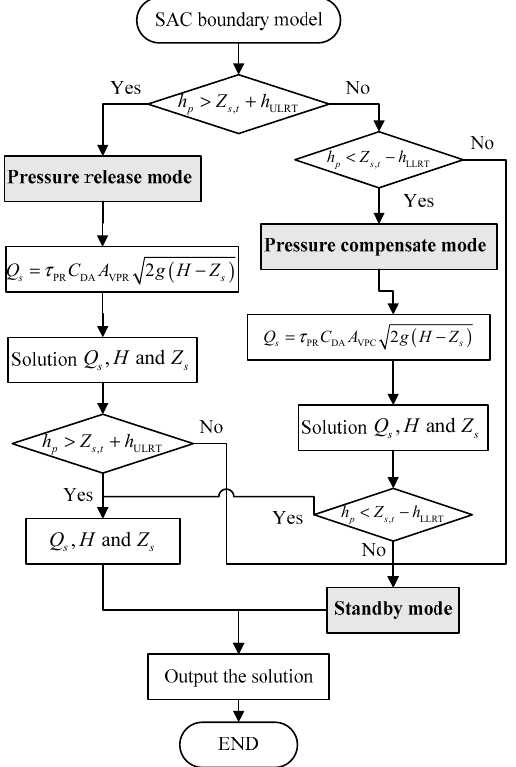
Figure 4. Flowchart of the simulation of the intelligent surge tank (IST) with SAC.